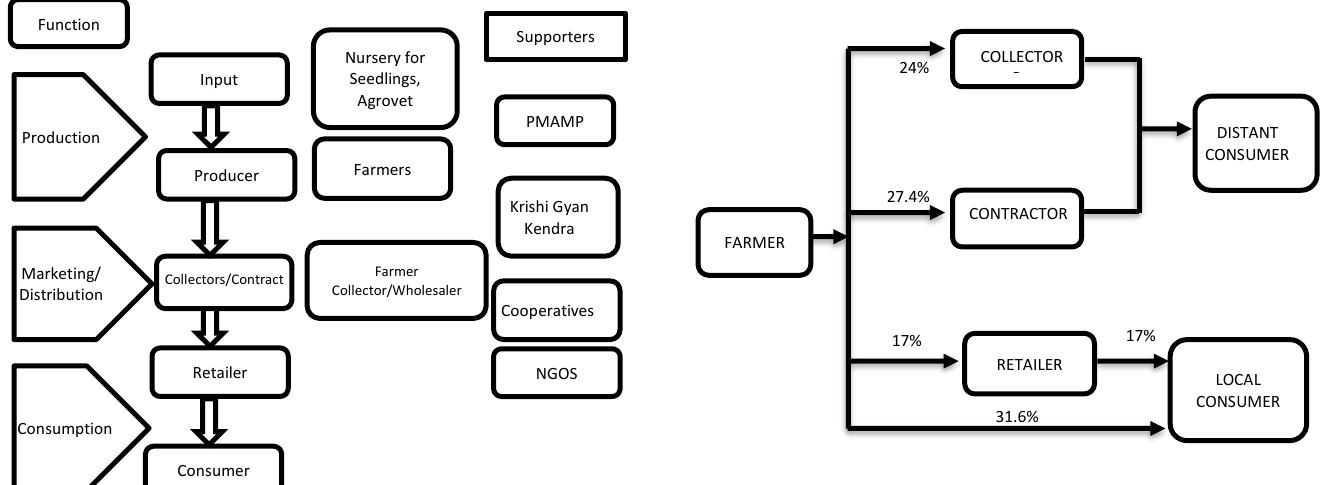
Figure 3: Volume mapping in Jajarkot